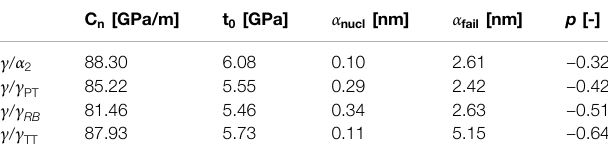
TABLE 4 | Parameters of cohesive zone model for Type-2 interface models determined from fi tting the results of MD simulations T (cid:2) 900